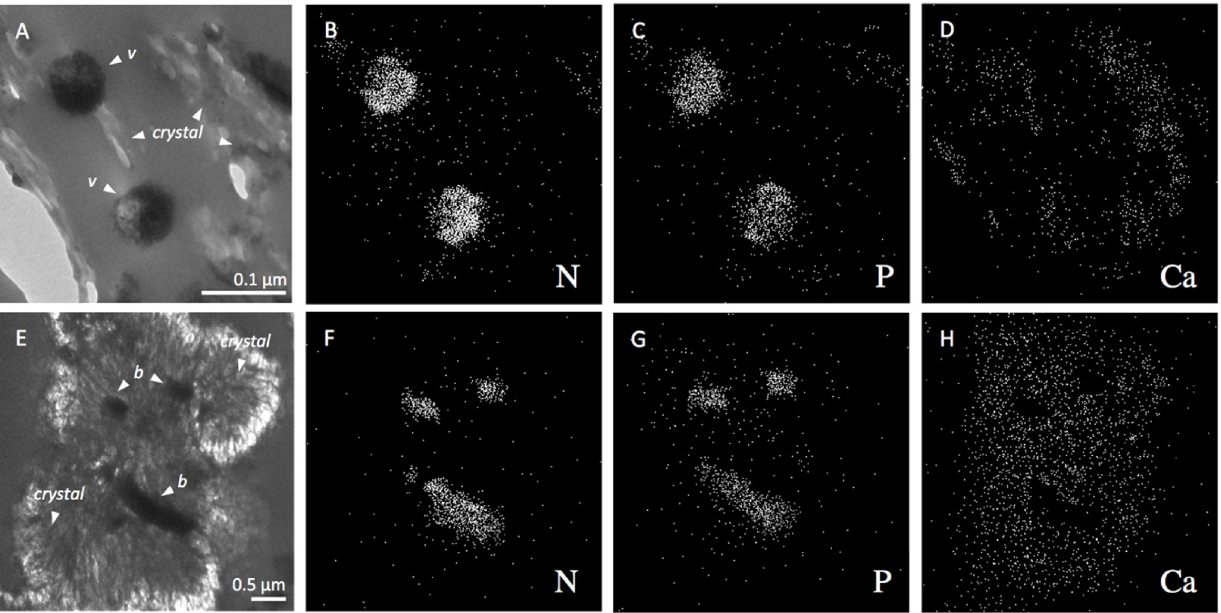
Fig 5. TEM image of cross-sections of high-Mg calcite showing apparent polyhedral-like viruses marked v (A) and bacteria marked b (E), and their elemental composition shown for the same fields in (B, C, D) and (F, G, H), respectively. The XEDS maps of nitrogen (B, F), phosphorus (C, G), and calcium (D, H), respectively, showing that viruses and bacteria contain nitrogen and phosphorus, with calcium mainly located in the mineral part of the high- Mg calcite grain (Ca,Mg)CO 3